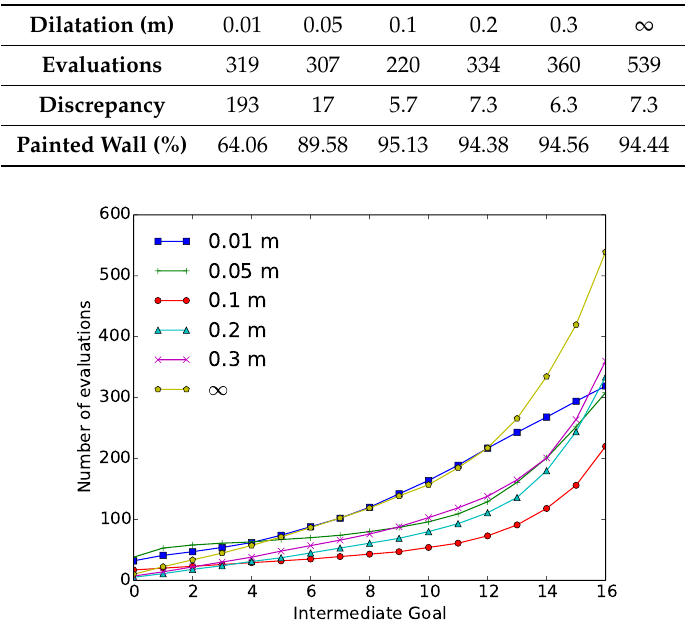
Figure 9. “Paint” geometrical constraint experiment results: Number of cumulative evaluations required at each intermediate goal as a function of the velocity constraint (0.01 m, 0.05 m, 0.1 m, 0.2 m, 0.3 m and ∞ ).